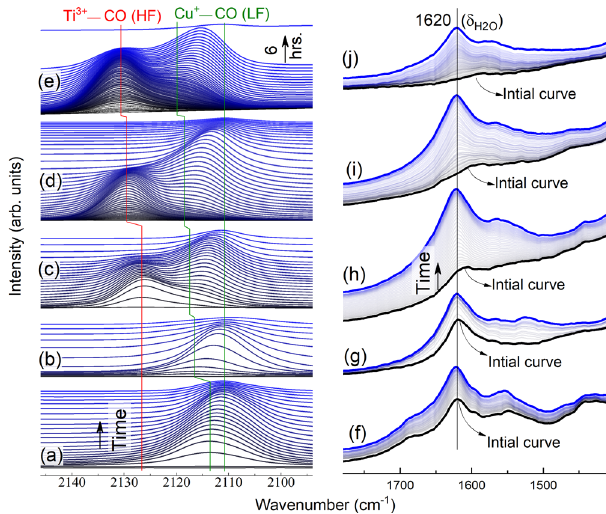
Fig. 2 DRIFTS spectra of Cu/TiO 2 after activation at different temperatures. Carbonyl ( a – e ) and the corresponding carbonate ( f – j ) regions of Cu/TiO 2 as a function of time (10 min between spectra) after pre-treatment under Ar fl ow at ( a , f ) 100 °C, ( b , g ) 150 °C, ( c , h ) 200 °C, ( d , i ) 300 °C, and ( e , j ) 400 °C. Spectra were collected after the samples are cooled to room temperature. The carbonyl region demonstrates the change in intensity and position of two distinct CO binding sites, low frequency (LF) and high frequency (HF), on Cu + and Ti 3 + , respectively. The corresponding carbonate region indicates the surface adsorbed water at 1620 cm − 1